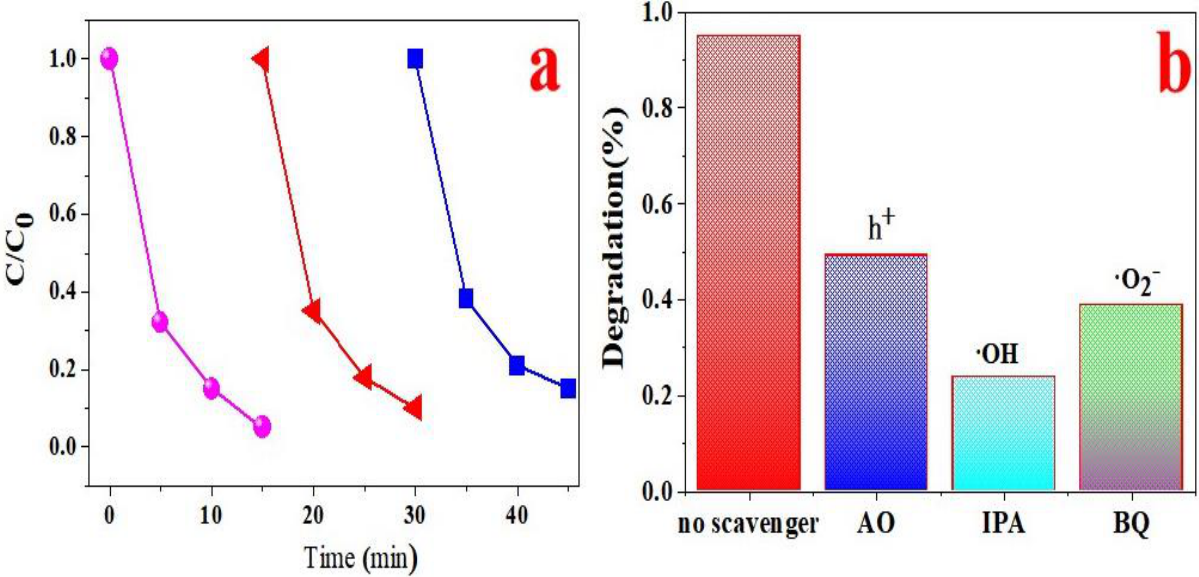
Figure 7. ( a ) PAN/g-C 3 N 4 /CdS cyclic stability to RhB degradation in sono-photocatalytic process. ( b ) The diverse carrier trapping on the RhB degradation for the PC-Cd-0.1 under the sono-photocatalytic system with a 75 W ultrasonic power.